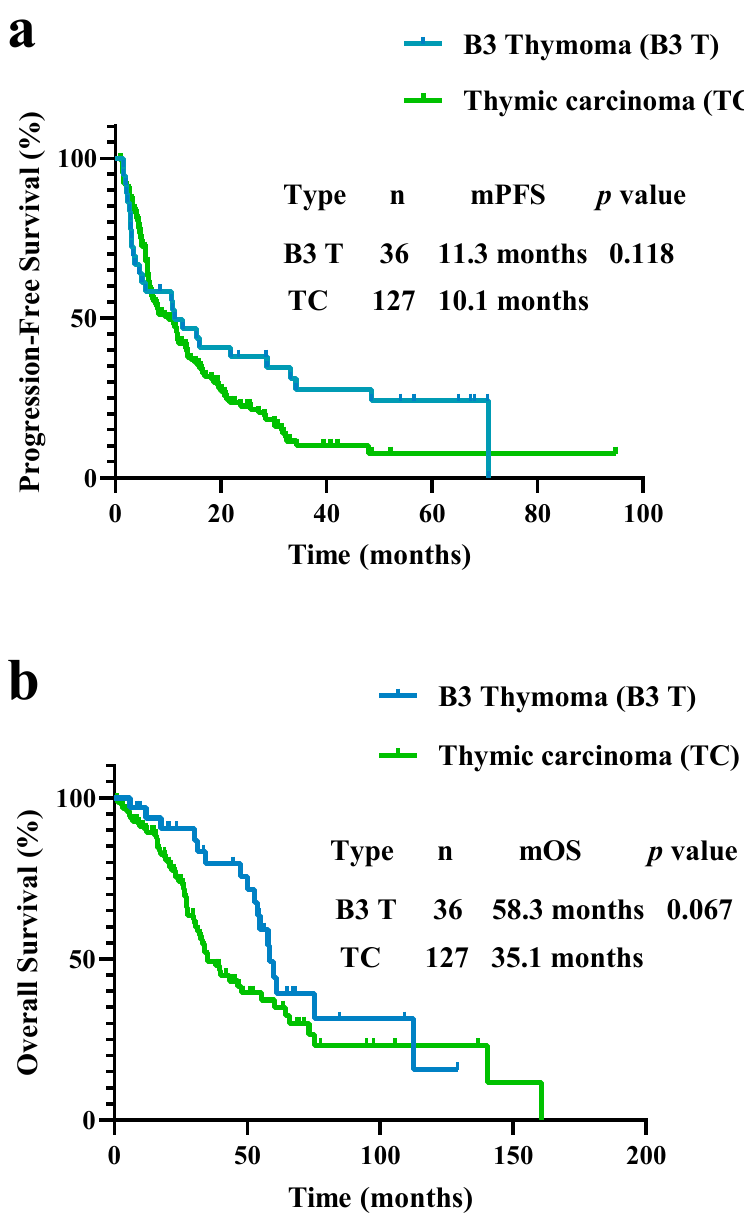
Figure 1. ( a ) Progression-free survival (PFS) and ( b ) overall survival (OS) in patients with B3 thymoma